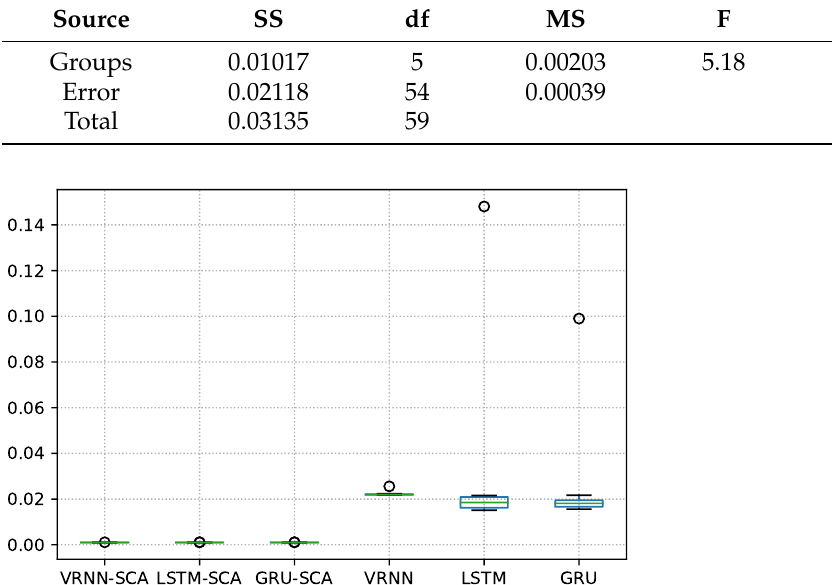
Figure 18. Boxplot differences on the 41060